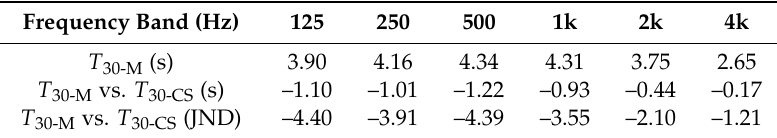
Table 5. A comparison of the reverberation time of the York Minster’s Chapter House in its current state ( T 30-CS ) and the estimation in its original state ( T 30-M ). Simulated values and di ff erences in terms of